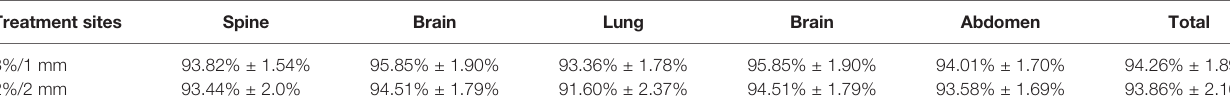
TABLE 2 | The mean and standard deviation of the passing rate based on the gamma index analysis. Treatment